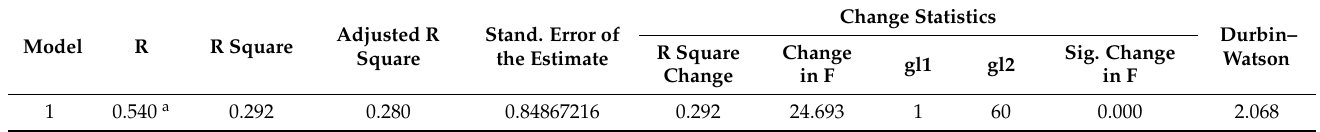
Table 3. Regression